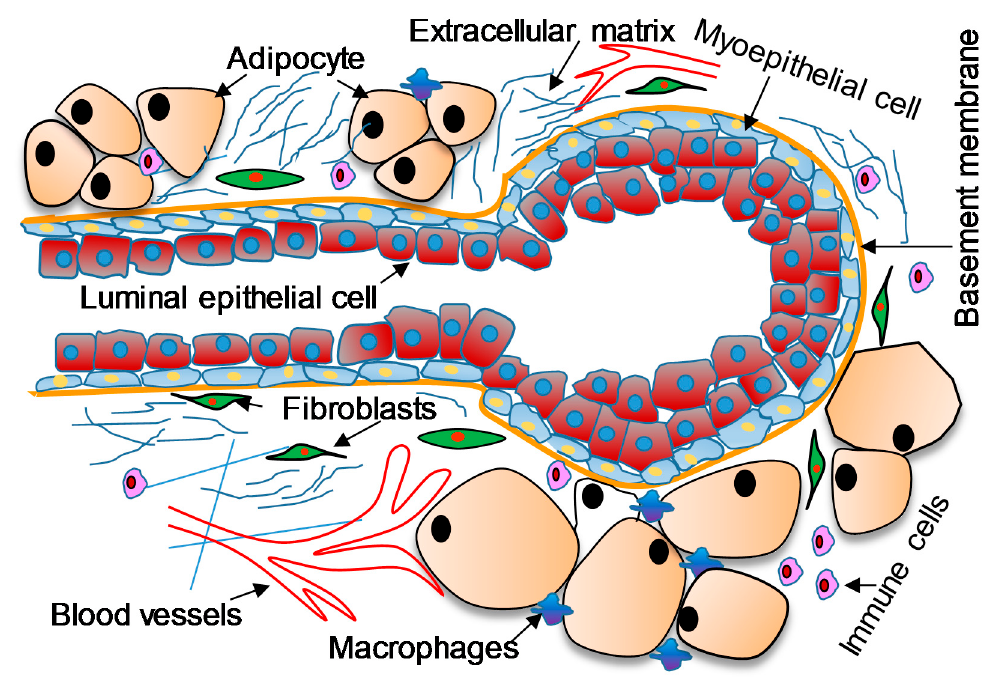
Figure 2. The complex tumor microenvironment of breast cancer.